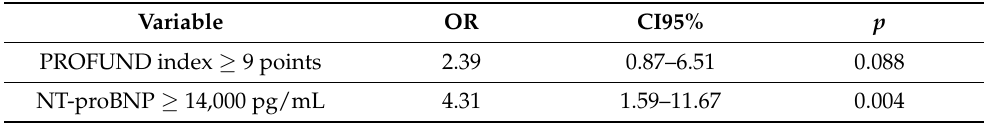
Table 4. Logistic regression for 30-day mortality factors in patients included in the PROFUND-IC registry.